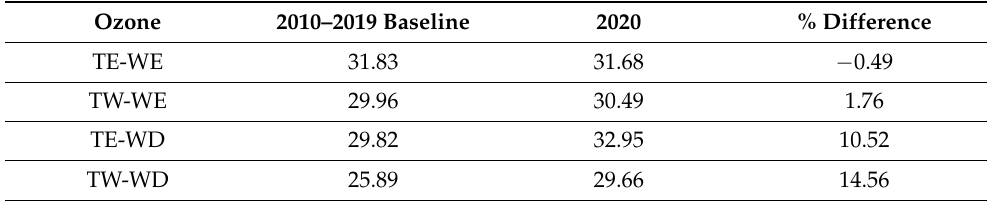
Table 3. The 3-month (April to June) aggregate results for O 3 for the baseline period (2010–2019) and 2020 and the percentage reduction for 2020 from the baseline period, analyzed for Toronto East (TE) and Toronto West (TW) for both weekends (WE) and weekdays